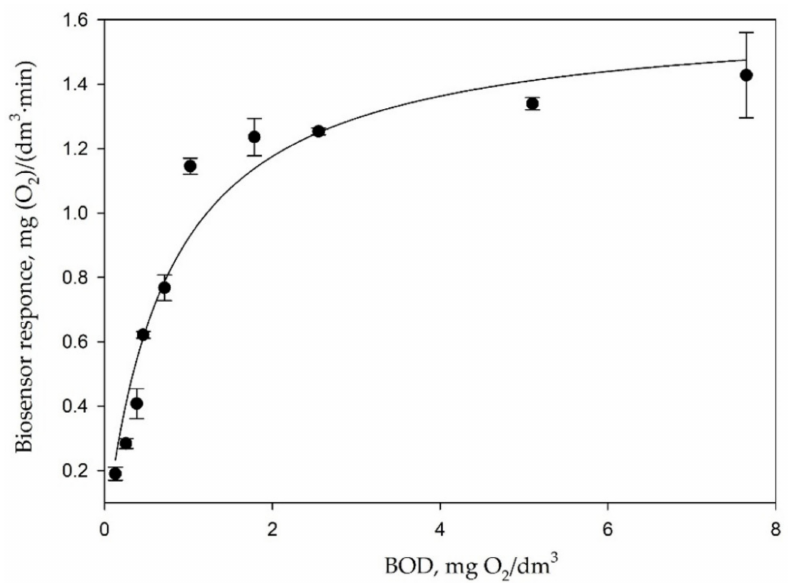
Figure 8. Calibration dependence of the response of a bacterial biosensor based on a sol–gel matrix to the content of biochemical oxygen demand.